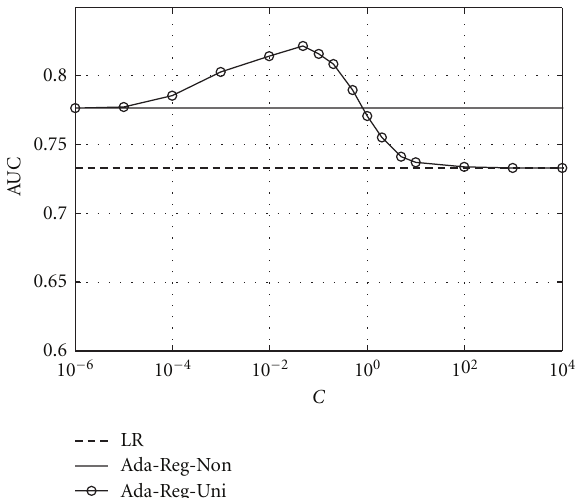
Figure 4: E ff ect of regularization prior in adaptive classifier Ada- Reg-Uni with parameter C varied between two extreme cases (i.e., C → 0 for no regularization, and C → ∞ regularization alone) and fixed N r = 100.